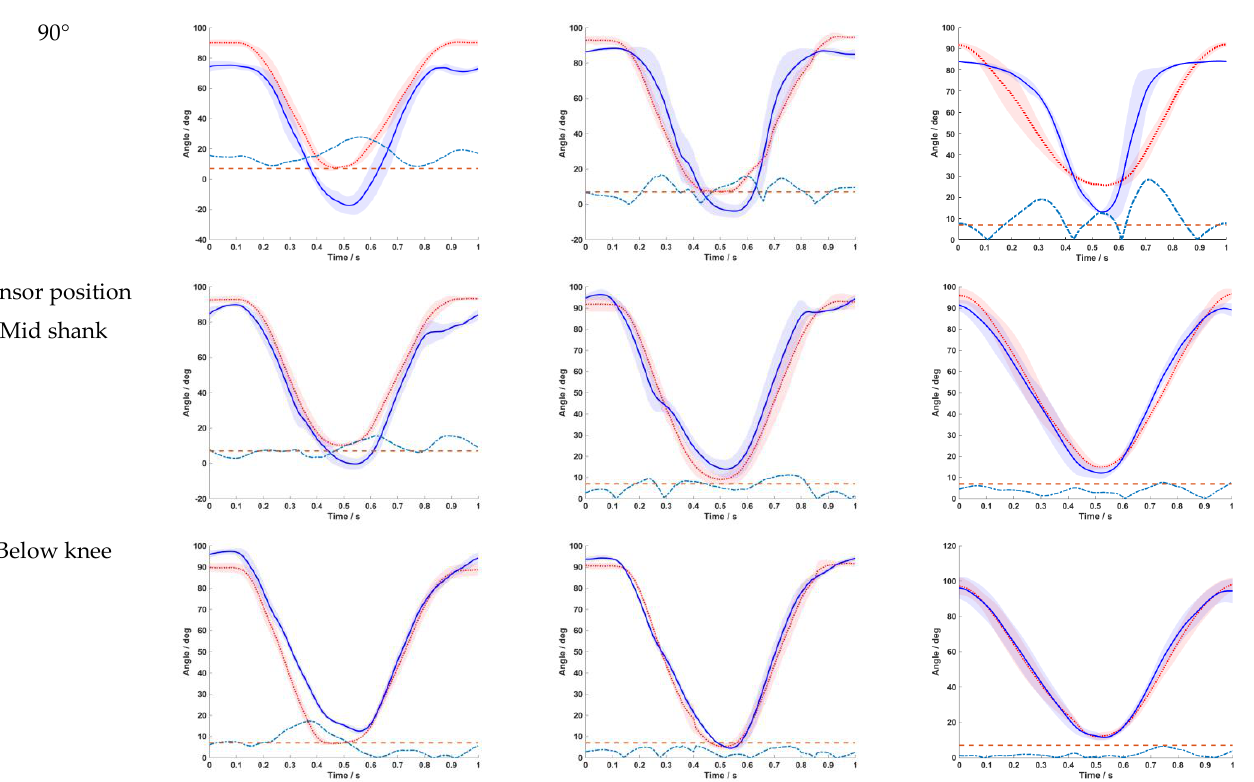
Figure A1. Data plots of the three test subjects in the different test situations showing the mean ± SD of the 5 normalized movement cycles for the BPMpathway (full blue line) and the BIOPAC goniometer (dotted red line) with the difference between the means (dashed turquoise line) and the 7° tolerance threshold line (dashed red line).